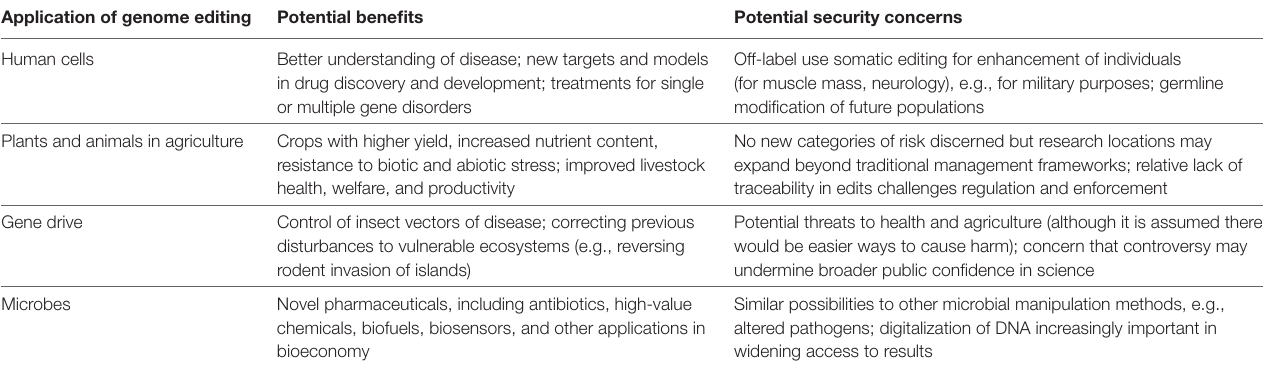
TABLE 1 | Examples of points emerging from workshop breakout session